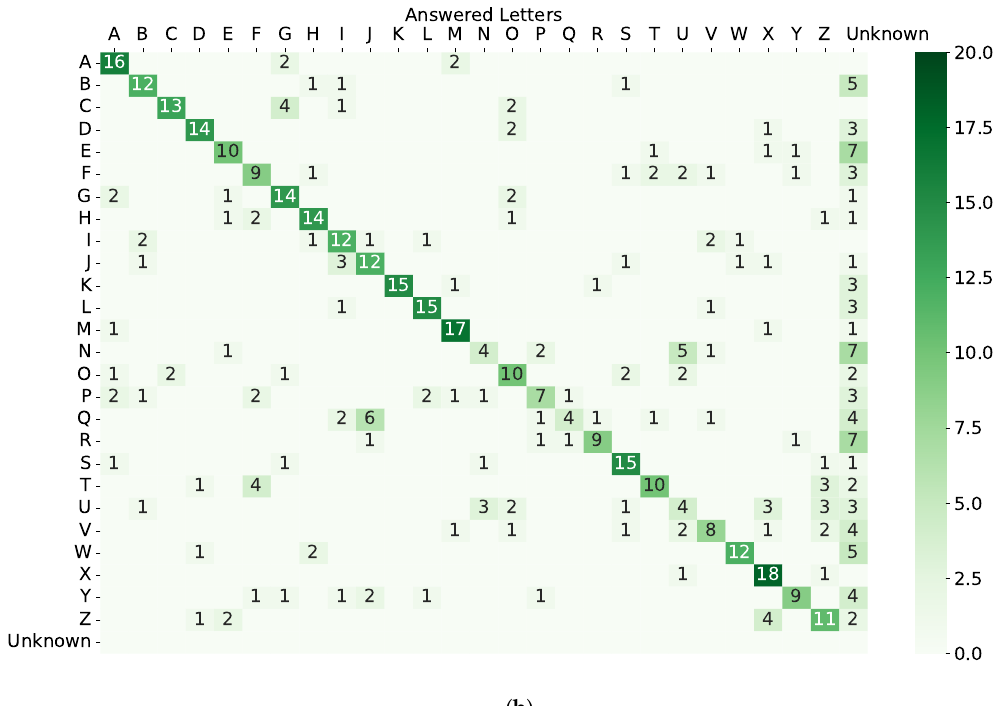
Figure 10. Confusion matrices across all participants. ( a ) Without movement illusion. ( b ) With movement